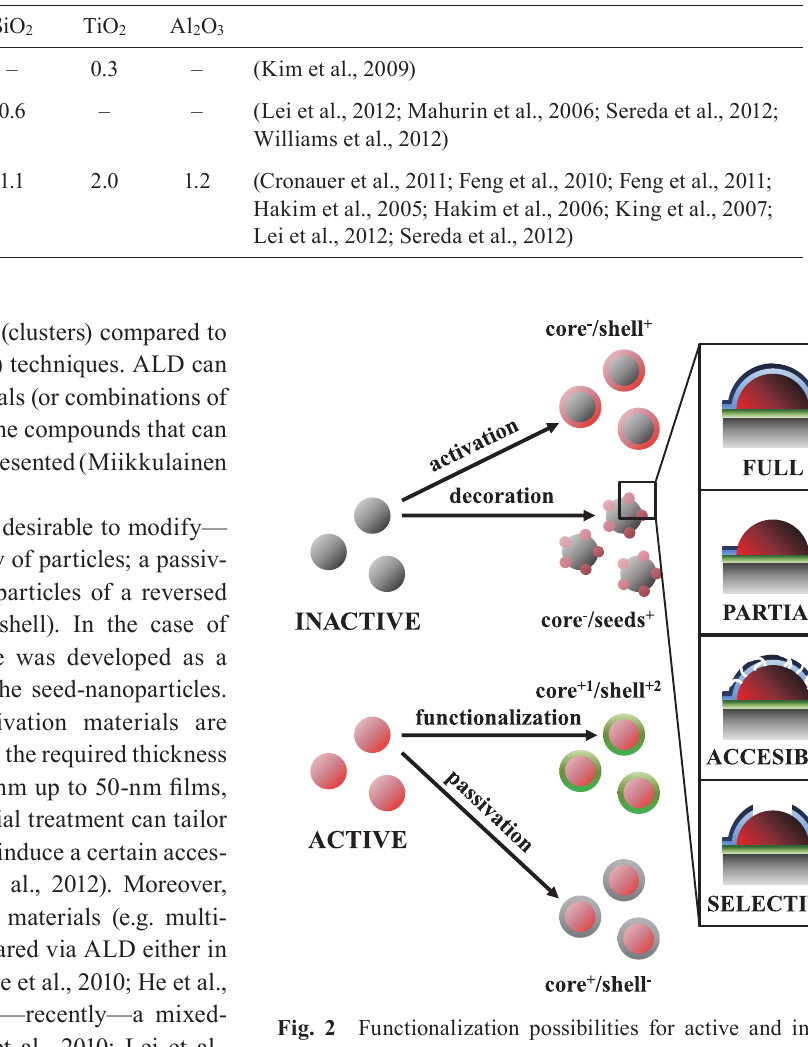
Table 2 Growth per cycle (GPC) of ALD-deposited common oxides (TiO 2 , SiO 2 , Al 2 O 3 ) on oxide powders (supports). Support